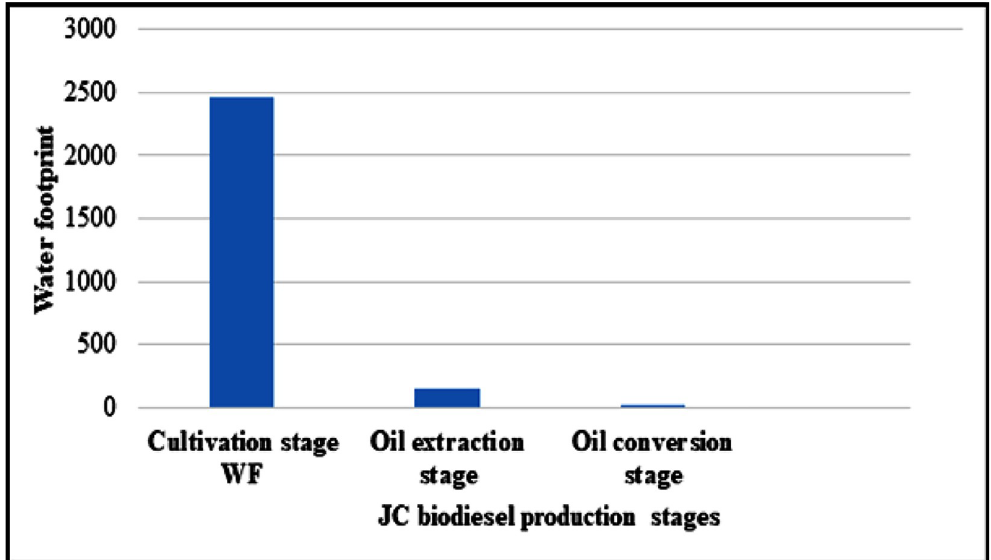
Fig 5. Water footprint of JC biodiesel production chain in